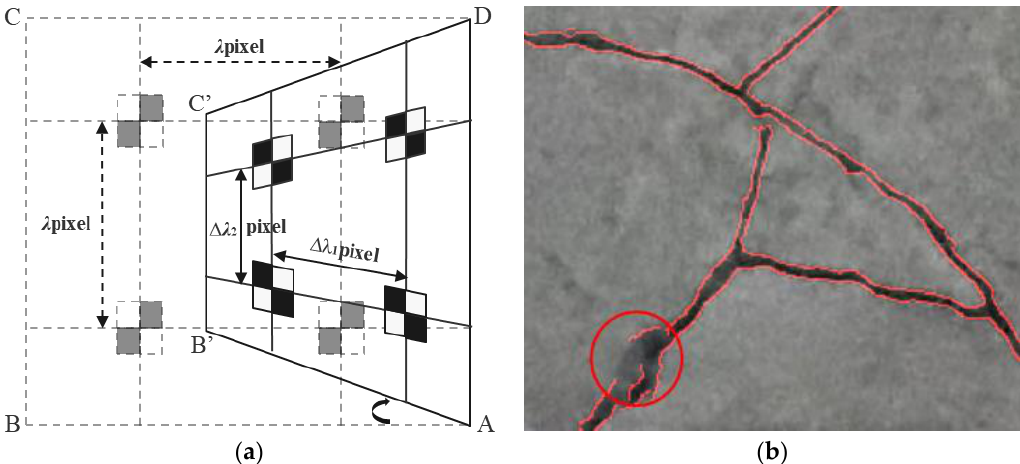
Figure 2. Problems of machine vision measurement methods. ( a ) Images of calibration board from side direction; ( b ) edges detected by Canny method, red circle is the discontinuous part.